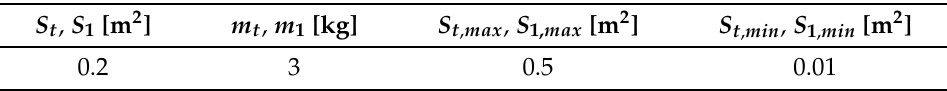
Table 1. Spacecraft physical parameters, subscripts 1 and t denote chaser 1 and target, respectively. S t , S 1 [m 2 ]